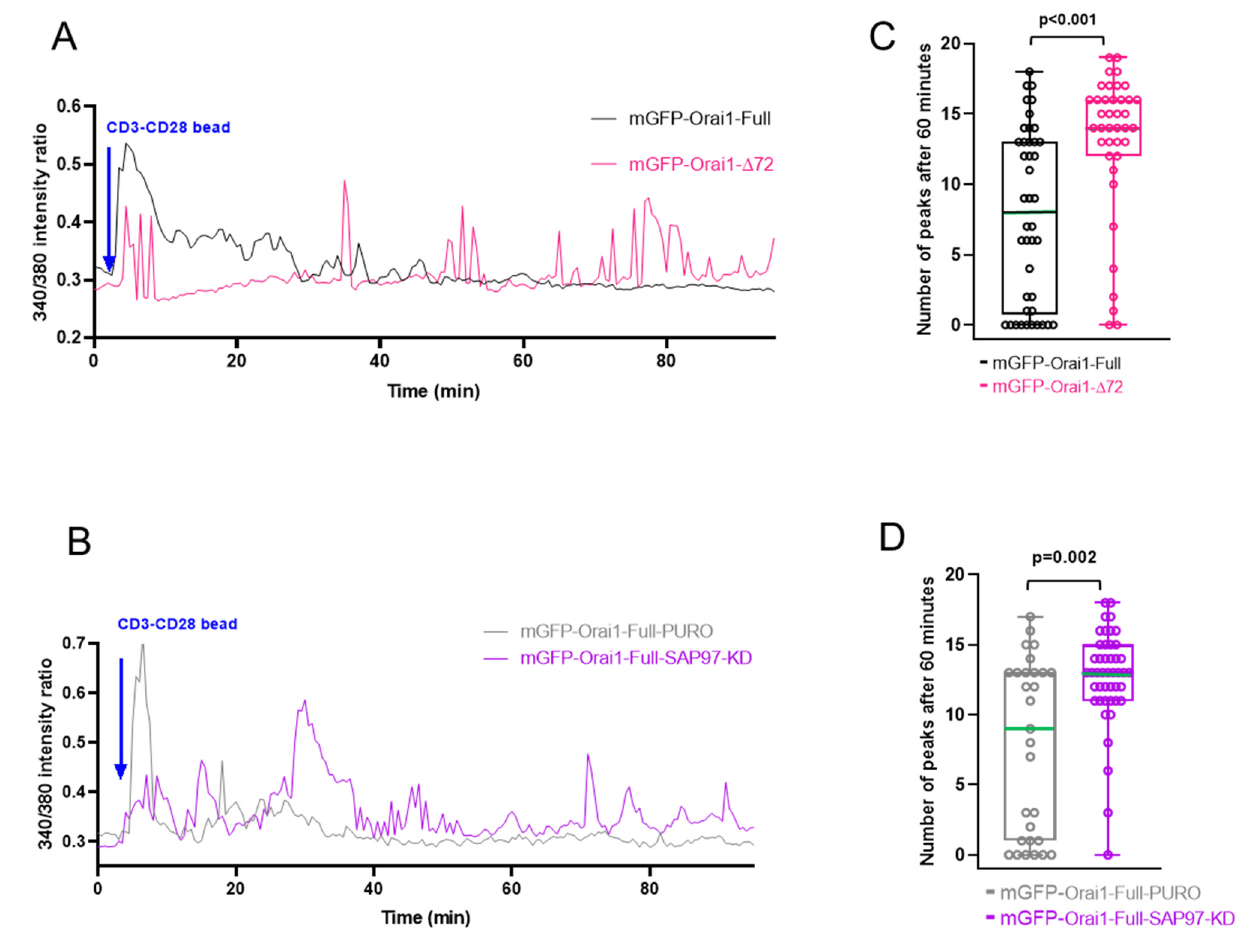
Figure 8. Sustained IS residency leads to calcium oscillation. Representative traces of cytosolic Ca 2+ measurements using FURA-2 in Jurkat cells stably expressing ( A ) the Orai1 wild-type (mGFP-Orai1-Full), Orai1-N terminally truncated channels (mGFP-Orai1- ∆ 72) ( B ) Orai1 wild-type missing SAP97 (mGFP-Orai1-Full-SAP97-KD), and Orai1 wild-type transfected with control shRNA (mGFP-Orai1-Full-PURO) upon forming immunological synapse with CD3-CD28 beads. Arrow indicates addition of CD3-CD28 beads. ( C , D ) Calcium response in different cell types between 60th and 90th minute after the IS was formed with beads (see materials and methods). For this experiment 42 cells of mGFP-Orai1-Full, 39 cells of mGFP-Orai1- ∆ 72, 45 cells of mGFP-Orai1-Full-SAP97-KD and 29 cells of mGFP-Orai1-Full-PURO were used, from 3 independent experiments. Dots represent the number of calcium peaks between 60th and 90th minute for each cell. Green line indicates median.